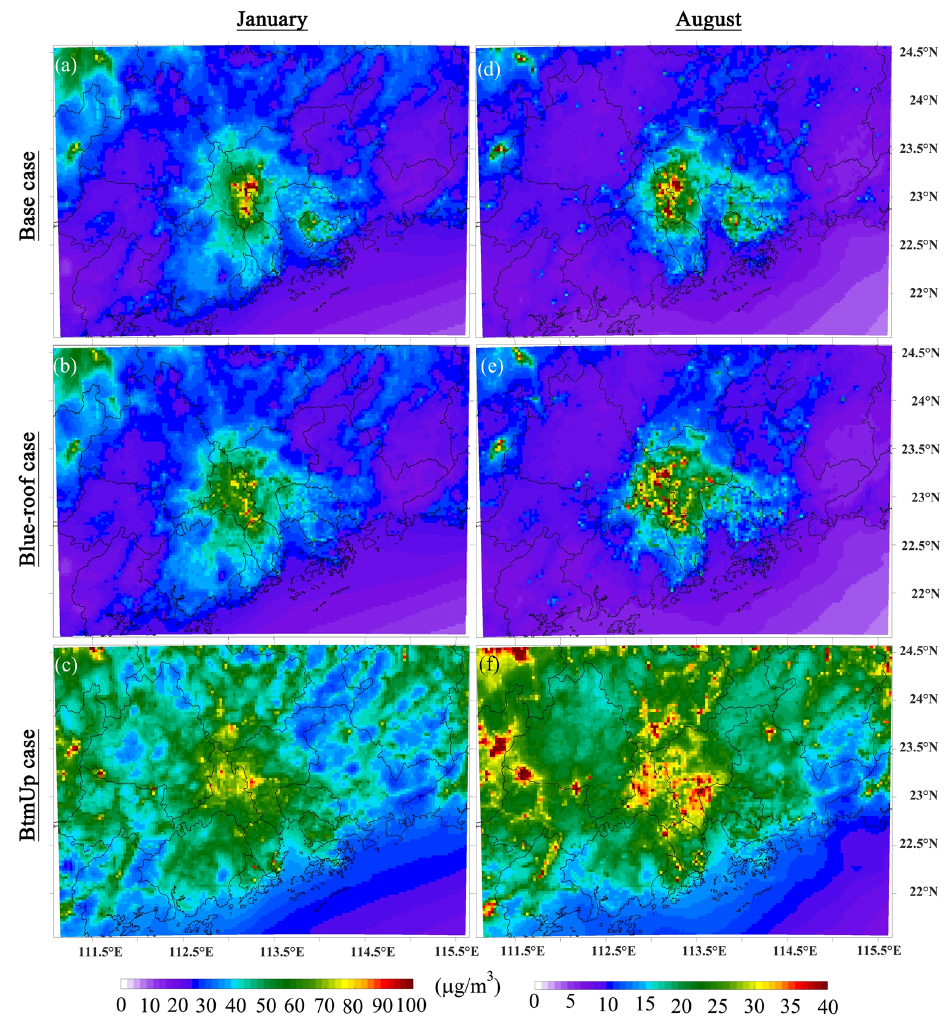
Figure 6. CMAQ-predicted monthly surface PM 2 . 5 : (a) January base case, (b) January blue-roof case, (c) January point- and area-based btmUp case, (d) August base case, (e) August blue-roof case, and (f) August point- and area-based btmUp case.